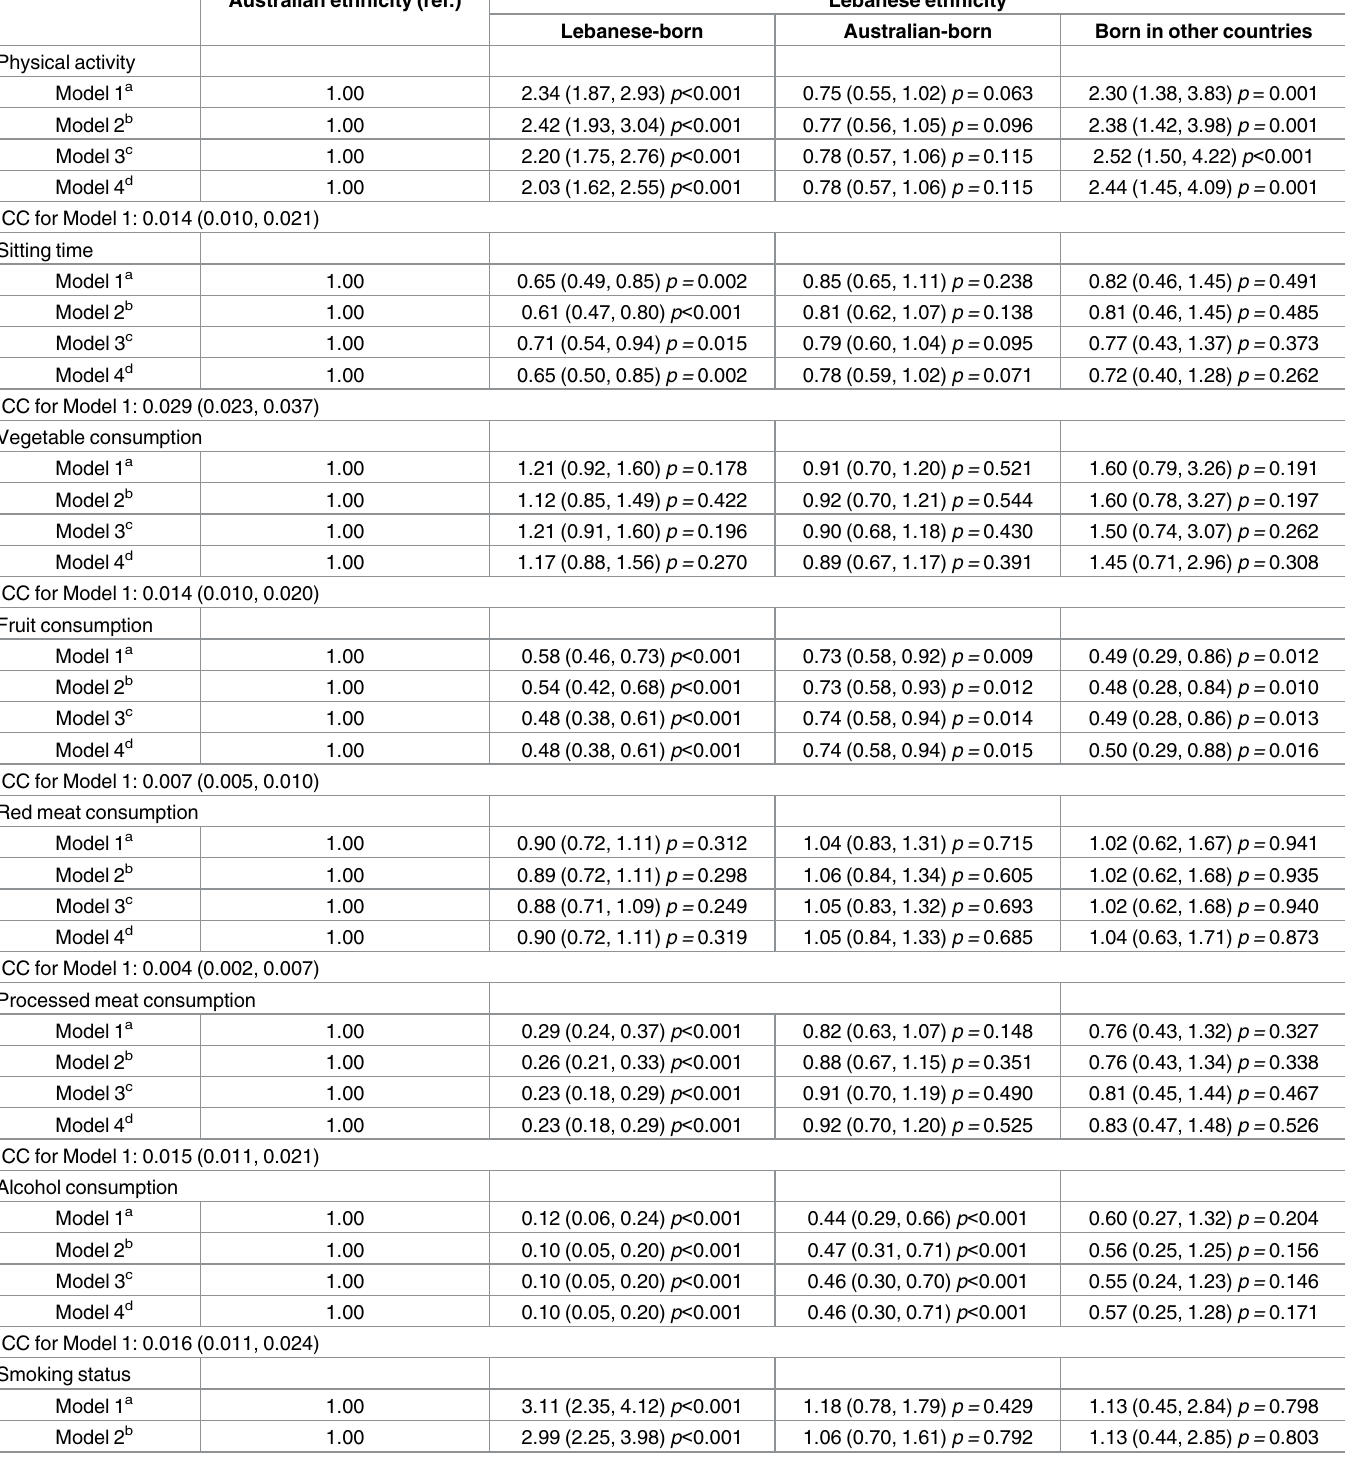
Table 2. Odds ratios (95% CI) for reporting suboptimal lifestyle behaviours among those of Lebanese ethnicity relative to those of Australian ethnicity. Australian ethnicity